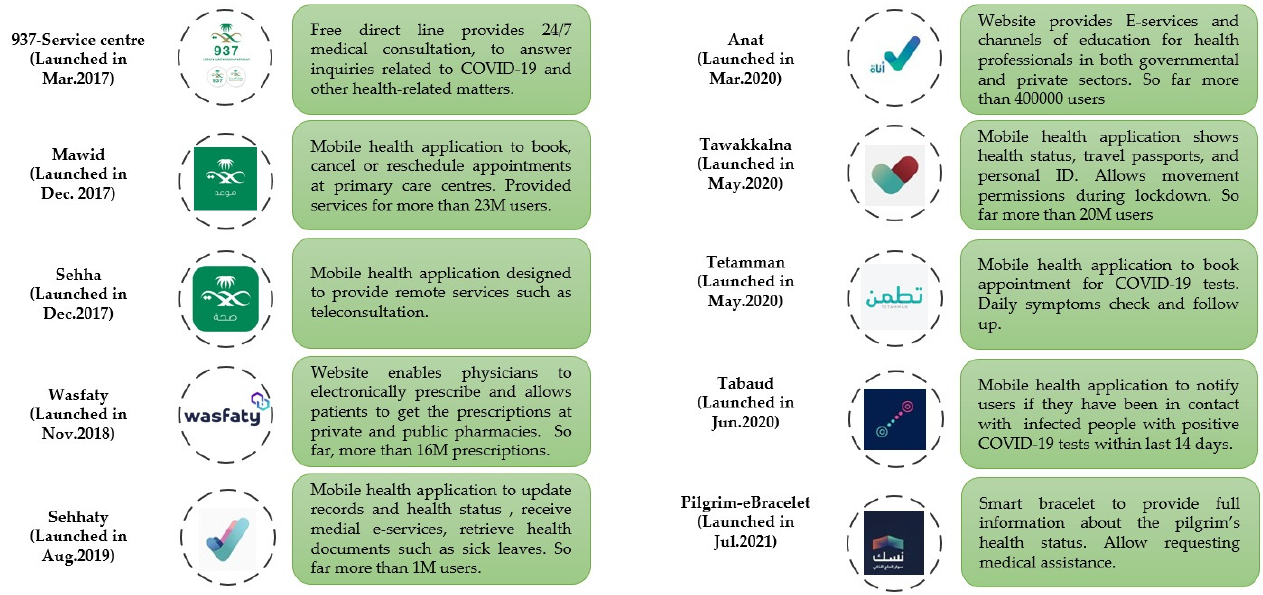
Figure 1. The timeline of optimising DHTPs in Saudi Arabia. Different DHTP applications were launched before, during, and after the COVID-19 pandemic.